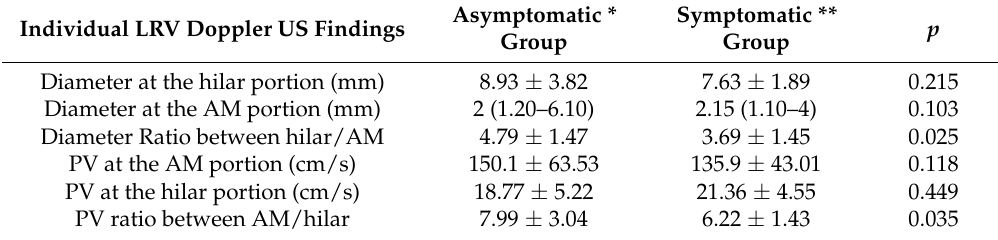
Table 2. Renal Doppler findings of the left renal vein in the asymptomatic/symptomatic group. Individual LRV Doppler US